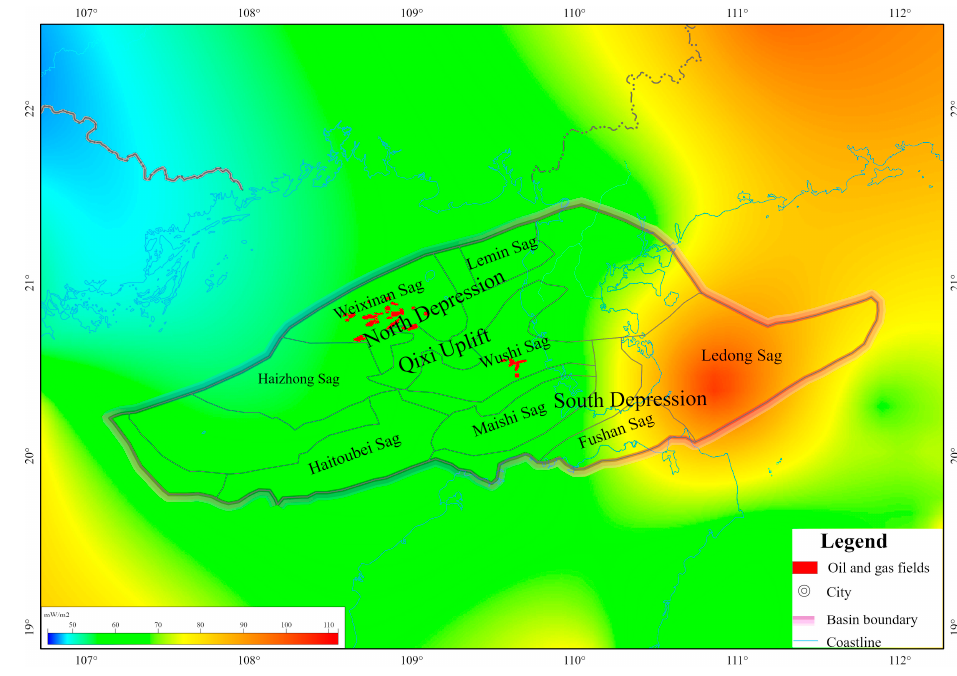
Figure 4. Characteristics of the geothermal field in the Beibu Gulf Basin.